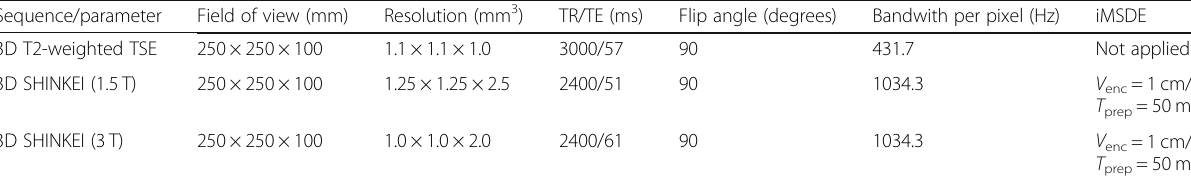
Table 1 Scan parameter settings of 3D T2-weighted TSE and 3D SHINKEI sequences Sequence/parameter